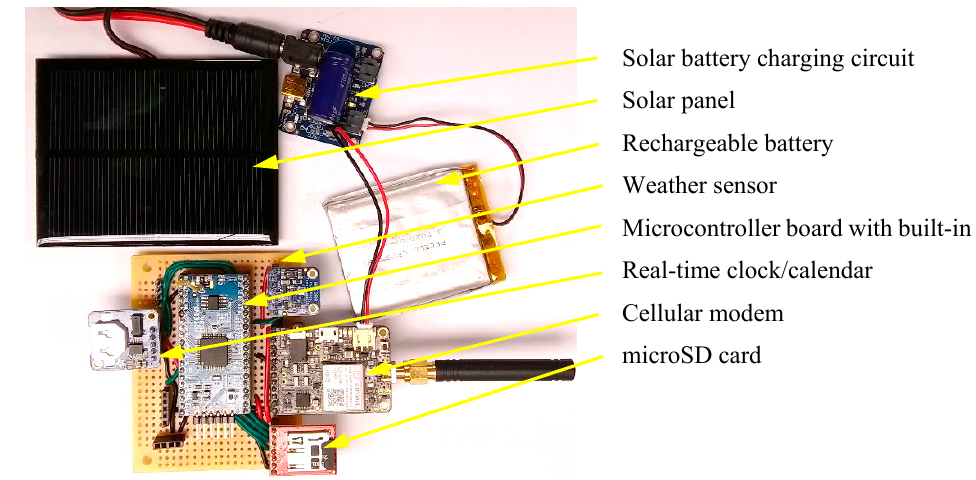
Figure 5. Cellular gateway. Figure 5. Cellular